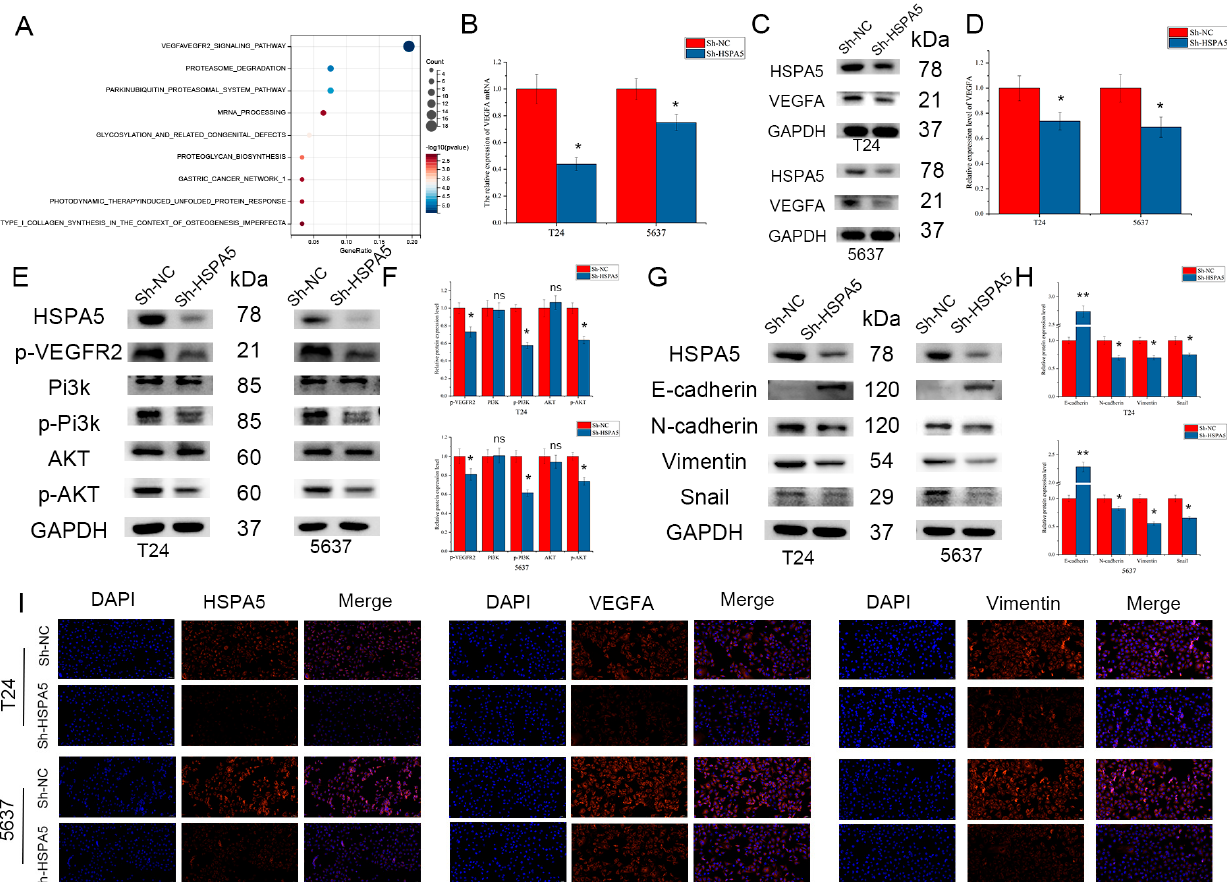
Figure 6. Inhibition of HSPA5 suppresses BCa progression by downregulating the VEGFA/VEGFR2 pathway. ( A ) Signaling pathway enrichment analysis showed that HSPA5 may regulate the VEGFA/VEGFR2 signaling pathway. ( B ) VEGFA mRNA and ( C , D ) protein expression after inhibi- tion of HSPA5. ( E , F ) HSPA5 could regulate the PI3K/AKT signaling pathway via VEGFA/VEGFR2. ( G , H ) HSPA5 is involved in the process of EMT. ( I ) The HSPA5, VEGFA and vimentin expression levels were measured by fluorescence microscopy in the sh-HSPA5 groups and control groups (200 × ). All data are presented as the mean ± SD. * p < 0.05, ** p <